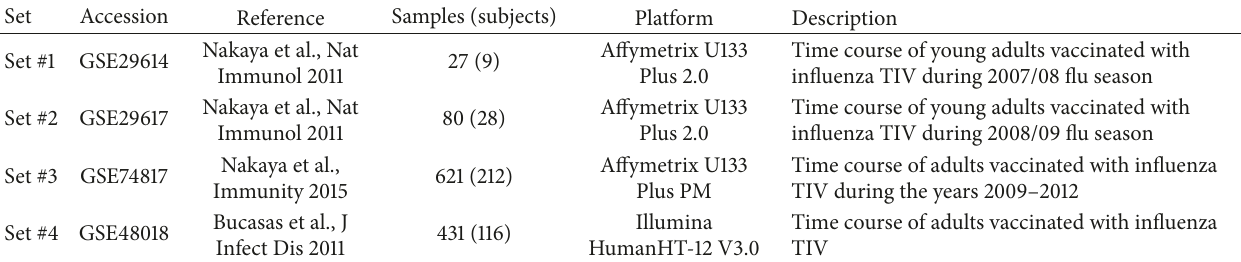
Table 1: Transcriptional data sets used in this